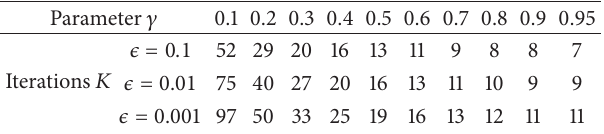
Table 6: The influence of the accuracy parameter 𝜖 and safety